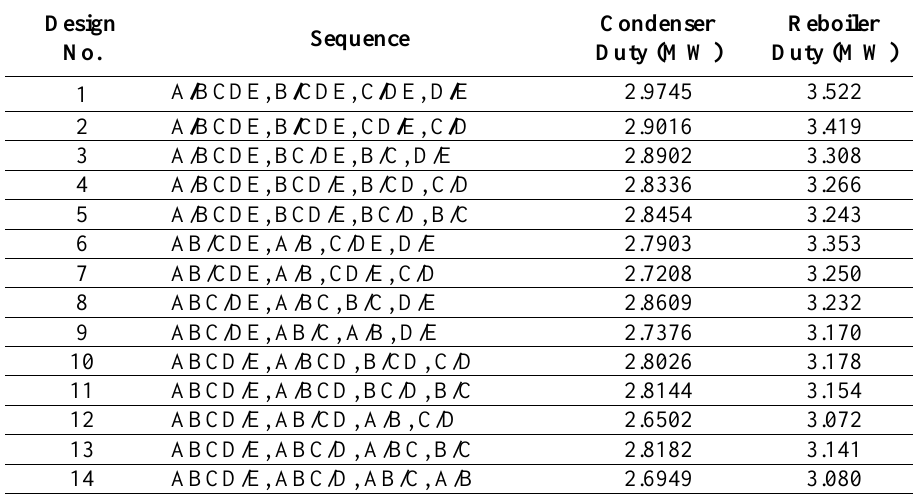
Table 5 Energy consumption at hot & cold utilities used to column